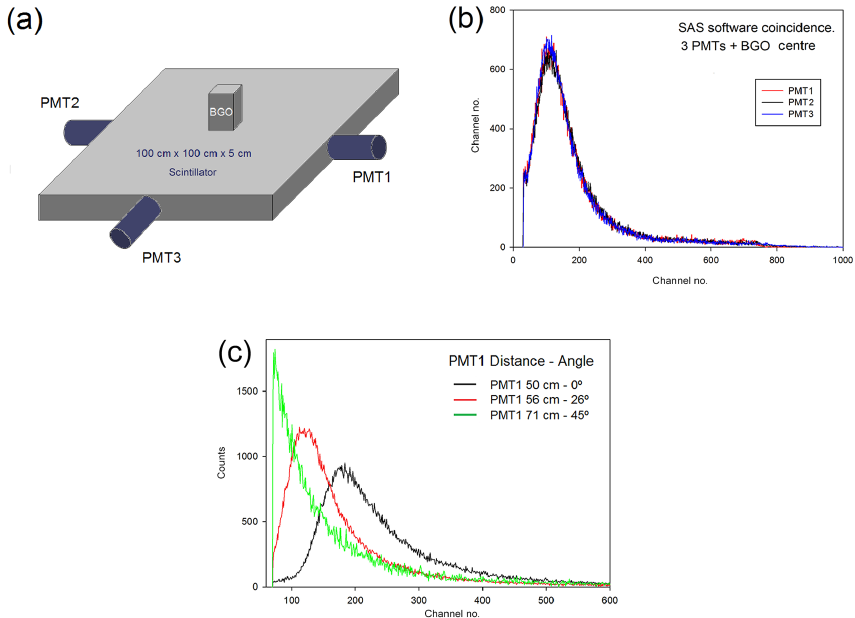
Figure 17. Software coincidence with four PMTs (MD2), three of them placed in the sides of a 100cm × 100cm × 5cm scintillator. The fourth one is set with a 6cm × 2cm bismuth germanate scintillator (BGO). Coincident particle tracks pass through a relatively small region of the large scintillator, just under the BGO. When moving the BGO through the big scintillator surface, the histograms shift depending on the distance and the angle formed by the PMT axis and the line between the PMT and scintillator impact place. (a) Configuration sketch with the BGO in the centre of the big scintillator, (b) result histograms of the upper-left configuration and (c) result histograms with different distances and